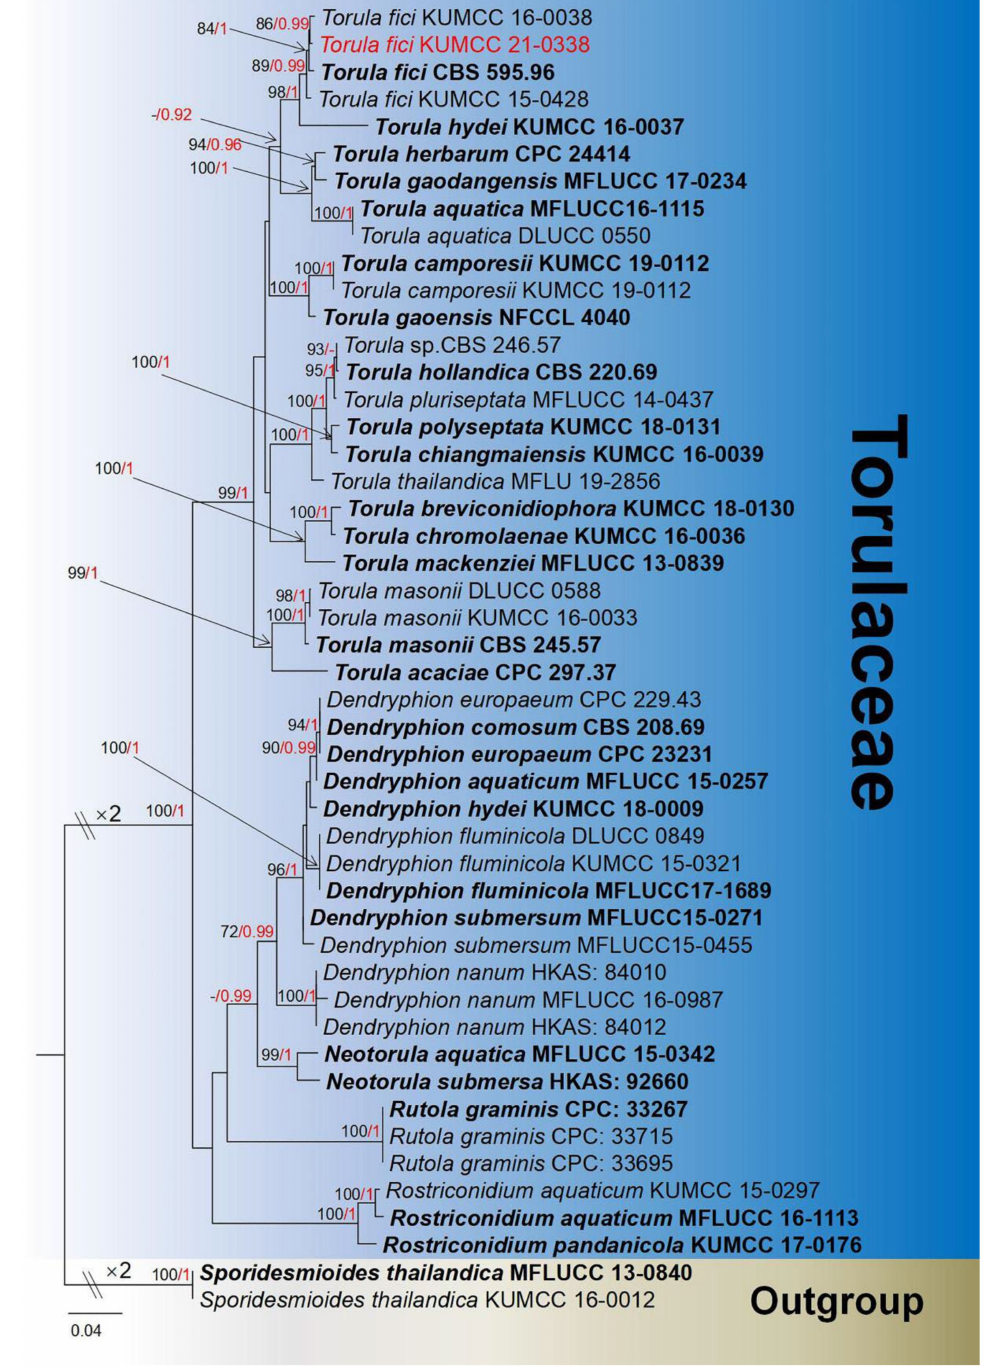
Figure 15. Phylogram generated from maximum likelihood analysis based on a combined LSU, SSU, ITS, tef1- α , and rpb2 sequence datasets. Related sequences were taken from Mapook et al. and Jayasiri et al. [16,59]. The 48 strains are included in the combined gene analyses’ 4399 total characters, including gaps (LSU: 1–882 bp, SSU: 883–1924 bp, ITS: 1925–2493 bp, tef1- α : 2494–3345 bp, rpb2 : 3346–4399 bp). Tree topology of the ML analysis was similar to the BI. The matrix had distinct alignment patterns, with the final ML optimization likelihood value of − 18,975.972644 (ln). All free model parameters were estimated by RAxML model, with 1271 distinct alignment patterns and 38.80% undetermined characters or gaps. Estimated base frequencies were as follows: A =